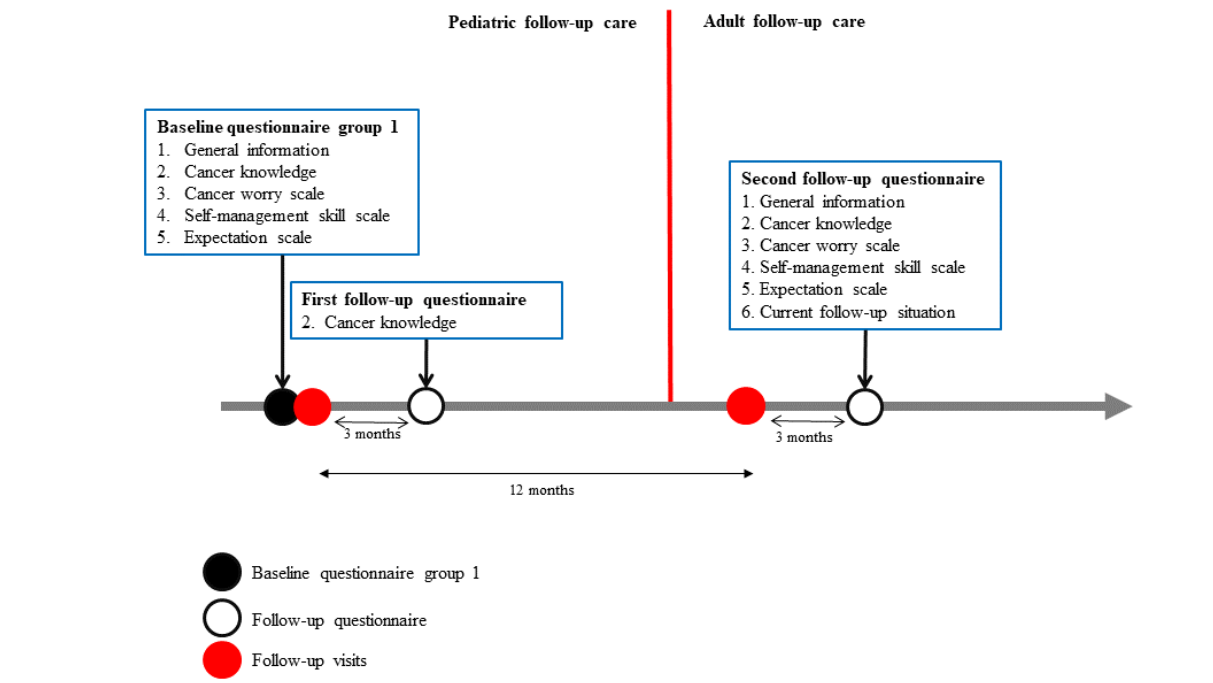
Figure 1. Timeline of the Aftercare of Childhood Cancer Survivors (ACCS) study and time points where group 1a participants answer questionnaires; questionnaire sections are numbered and identical numbers correspond to identical content.